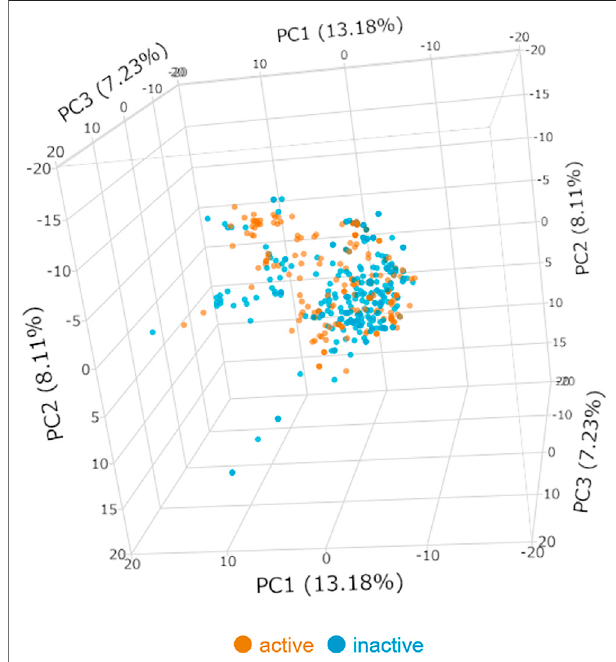
FIGURE 1 | Principal component analysis of the active or inactive compoundsofthetrainingdataset.PC (cid:1) principalcomponent.Bluedot:HSV- 1 inactive, orange dot: HSV-1